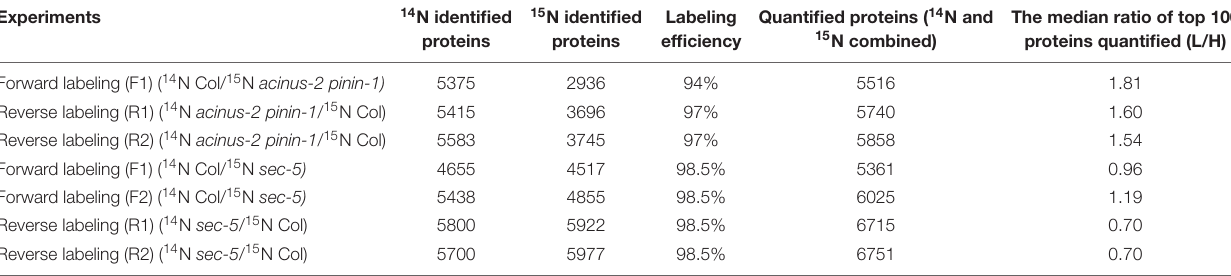
TABLE 2 | Summary of the identification and quantification data from seven biological experiments. Experiments